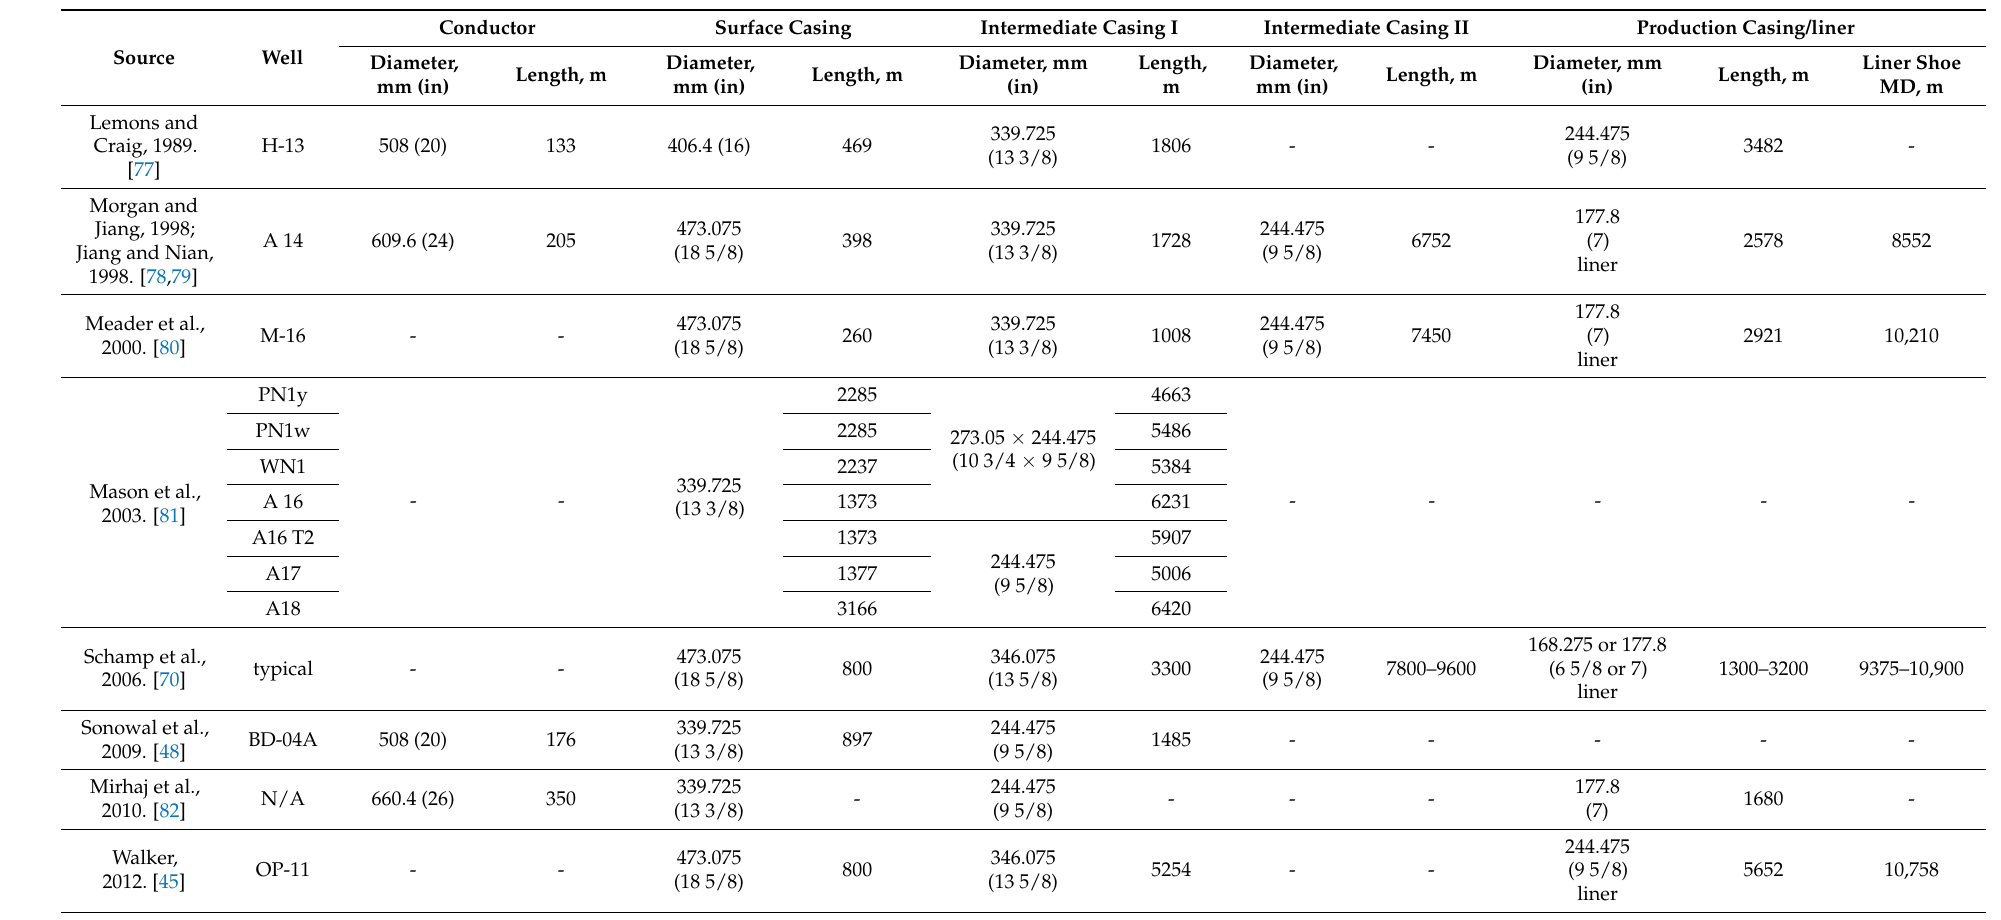
Table 3. The construction of the analyzed extended-reach